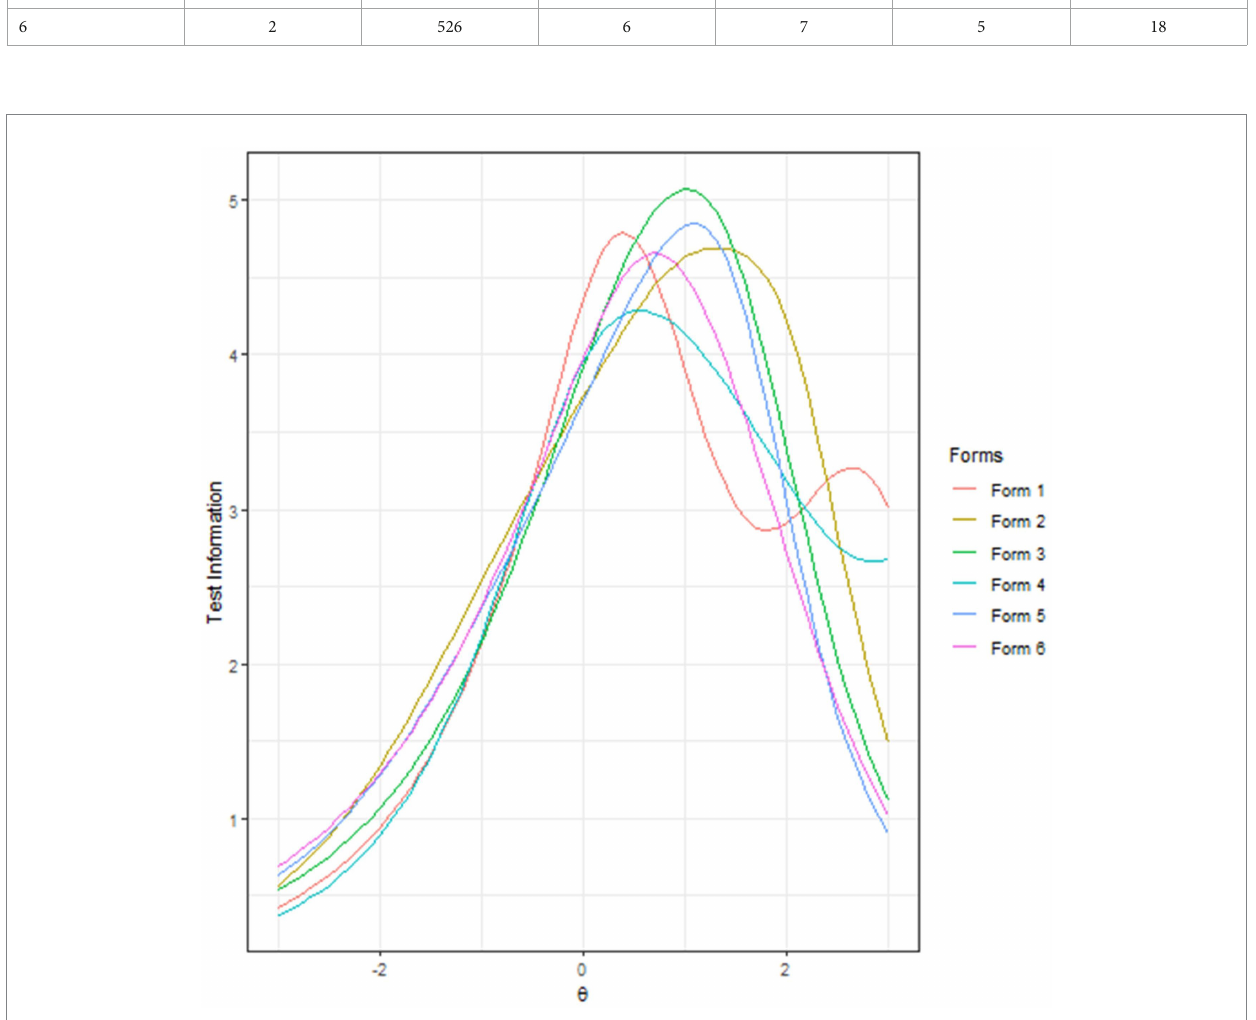
FIGURE 2 Test information functions at a given ability level θ of six equivalent test